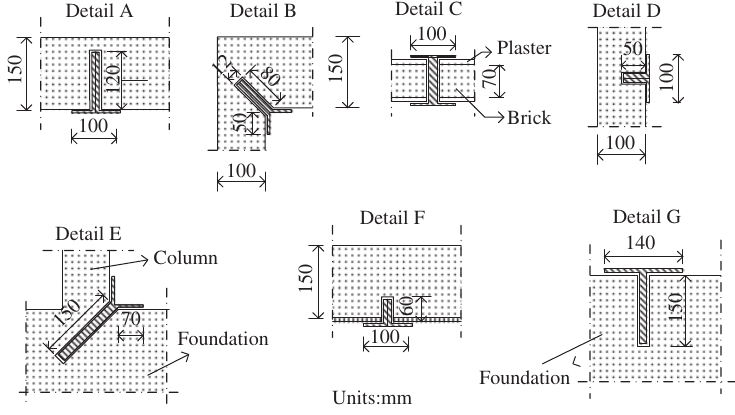
Figure 5 Anchor details.